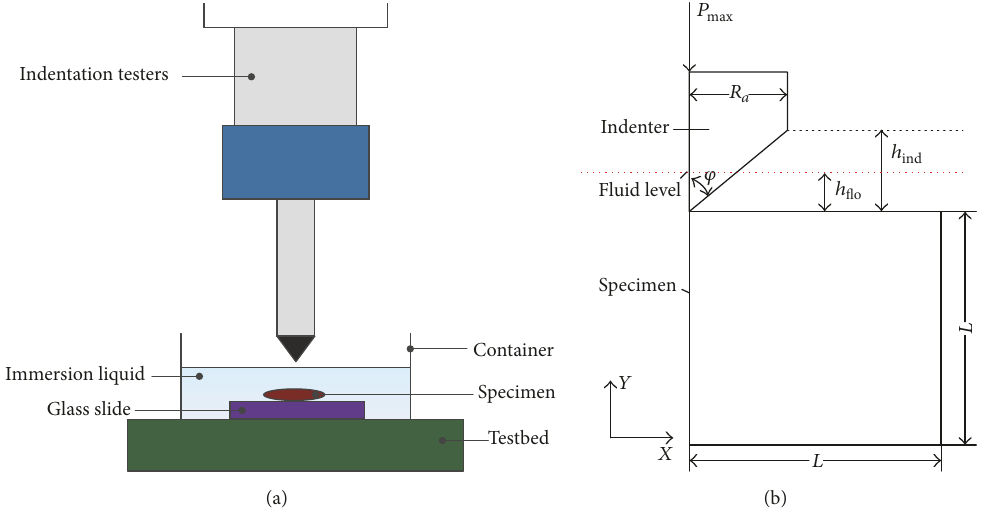
Figure 1: (a) Sketch map of immersion indentation experiment and (b) two-dimensional axisymmetric experiment model of nanoindenta- tion.